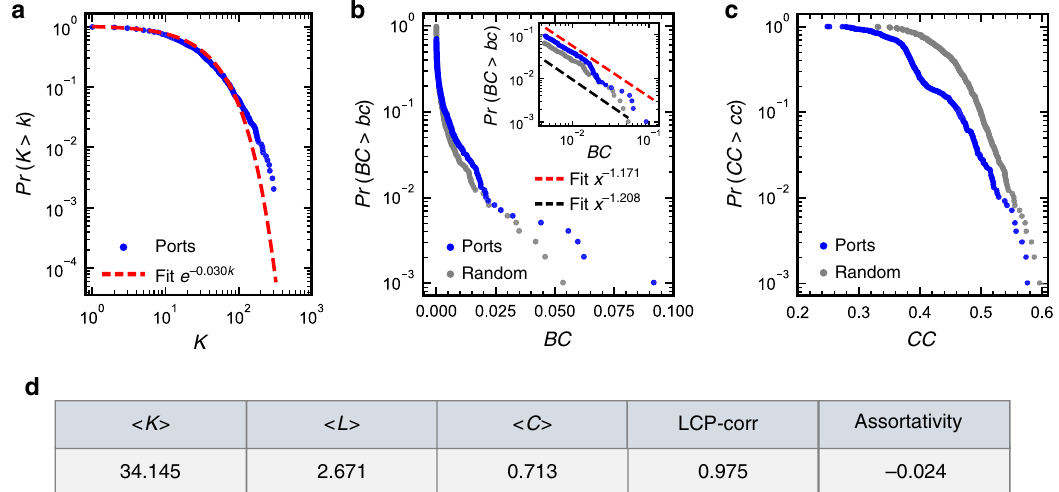
Fig. 2 Basic topological properties of the GLSN. In ( a ), complementary cumulative distribution function of degree is reported in log-log scale (dots), fi tted by an exponential function (dash line) instead of power-law; tests on the power-law distribution of the data failed based on the method of Clauset et al. 59 and the method of Voitalov et al 60 as well. Complementary cumulative probability distributions of betweenness centrality ( BC ) and closeness centrality ( CC ) for ports are plotted in semi-log scale in ( b and c ), respectively, in comparison to an equivalent random network which exactly keeps the same degree distribution as the original GLSN. The inset in ( b ) reports in log-log scale a power-law tail (red dash line) in the betweenness distribution with an exponent 1.171, corresponding to ports with BC ≥ 0.0043 (dots); power-law-ness is tested based on the method of Clauset et al. 59 . For an equivalent random network, the betweenness distribution for nodes with BC ≥ 0.0043 decays with an exponent 1.208 (mean across 80.4% (804 out of 1000) iterations passing the test) (black dash line). The average closeness centrality of the GLSN (i.e., 0.382) is close to that of an equivalent random graph (i.e., 0.440, mean across 1000 iterations). The bottom panel d presents the average port degree < K >, average shortest path length < L >, average clustering coef fi cient < C >, degree assortativity coef fi cient and local-community-paradigm correlation (LCP-corr). To con fi rm these basic topological properties of the GLSN, we repeated the analysis by using the liner shipping service routes data of 2017. The results for the GLSN of 2017 are consistent with the present results for the GLSN of 2015 (Supplementary Fig. 1). Source data are provided as a Source Data fi le.